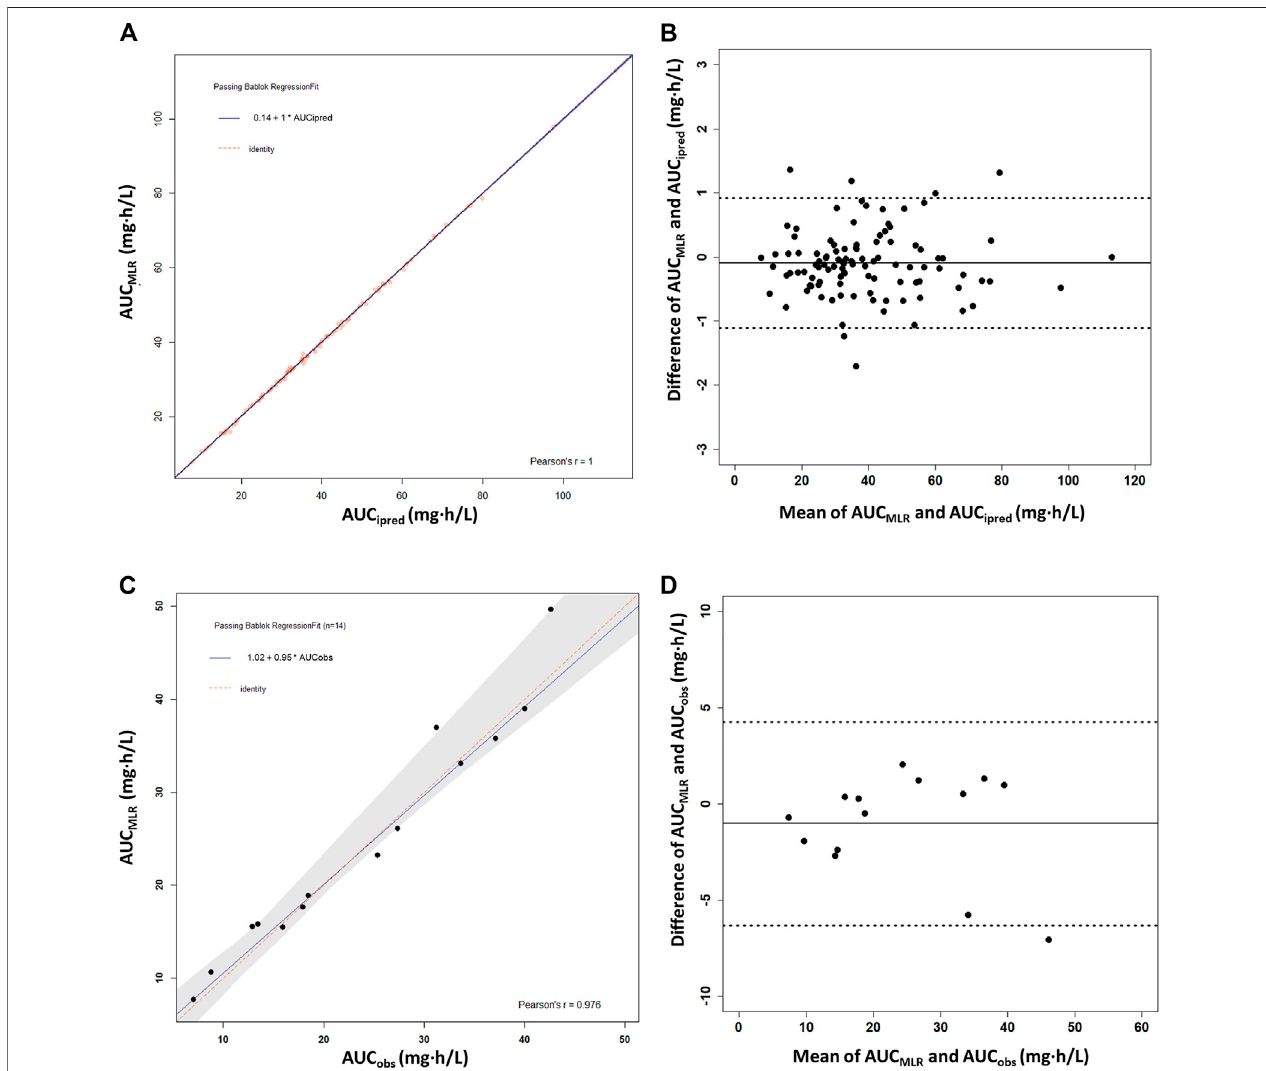
FIGURE 5 | Passing – Bablok regression analysis and the Bland – Altman plot between the reference AUC 0 – 12h and the calculated AUC 0 – 12h of MPA obtained using themultiplelinearregressionmodel(AUC MLR )inthehearttransplantrecipients. (A,B) AUC 0 – 12h obtainedbyPPKpredictionasthereferenceAUC 0 – 12h (AUC ipred )( n (cid:1) 91). (C,D) Observed AUC 0 – 12h values from the patients with intensive data as the reference AUC 0 – 12h (AUC obs ) ( n (cid:1) 14). AUC 0 – 12h , the area under the curve of the dosing interval; MPA, mycophenolic